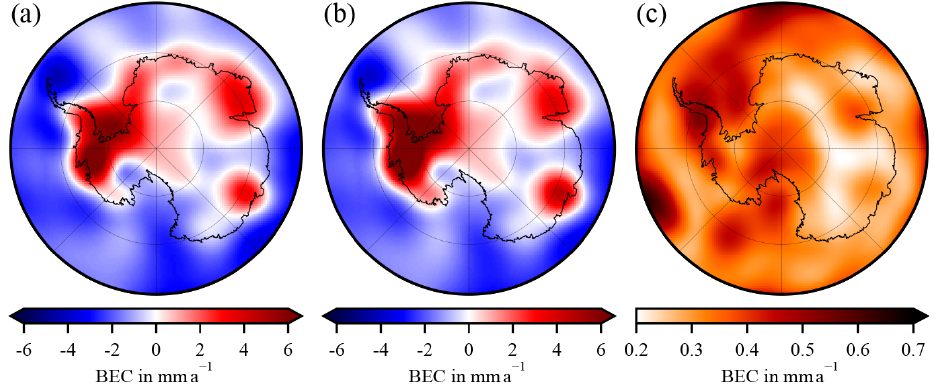
Figure 8. For the July 2010–August 2016 time period. (a) Debiased GIA bedrock elevation change (BEC) by combining time series of all data sets and models, (b) combination of trends, and (c) the formal uncertainty from least-squares estimation. Table 3. The comparison of integrated mass changes calculated in this study and those published in Gunter et al. (2014). For this we used GFZ RL05 GRACE solutions, ICESat-only altimetry, and RACMO2.1 products during March 2003–October 2009. Solution Total-mass GIA-related Ice